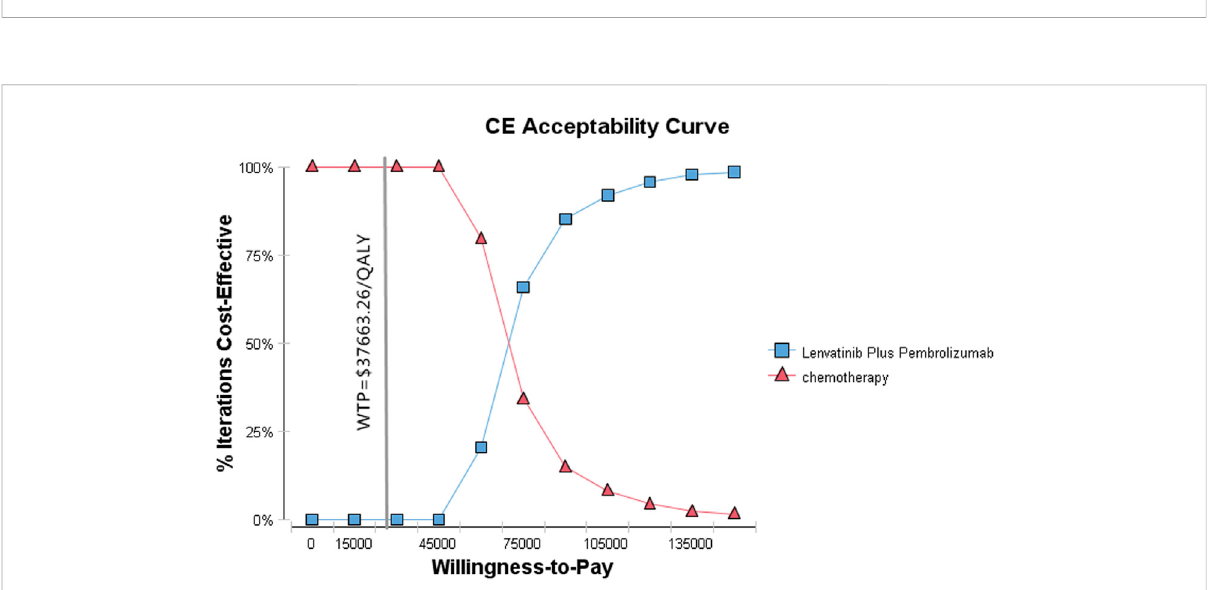
FIGURE 2 Tornado diagrams of one-way sensitivity analyses.